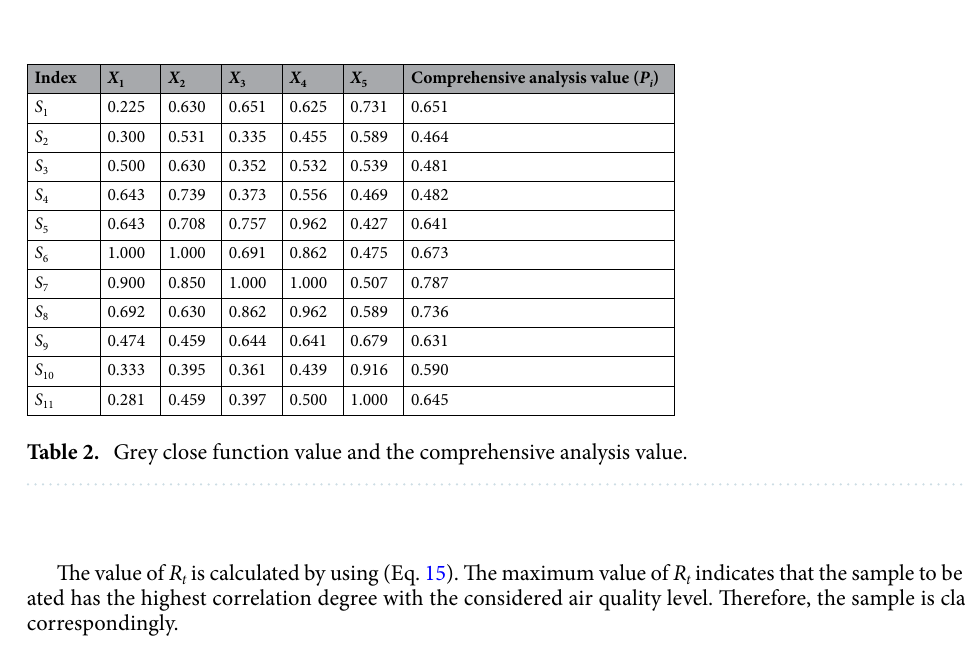
Table 1. Air quality in Ningxia Province in 2018.